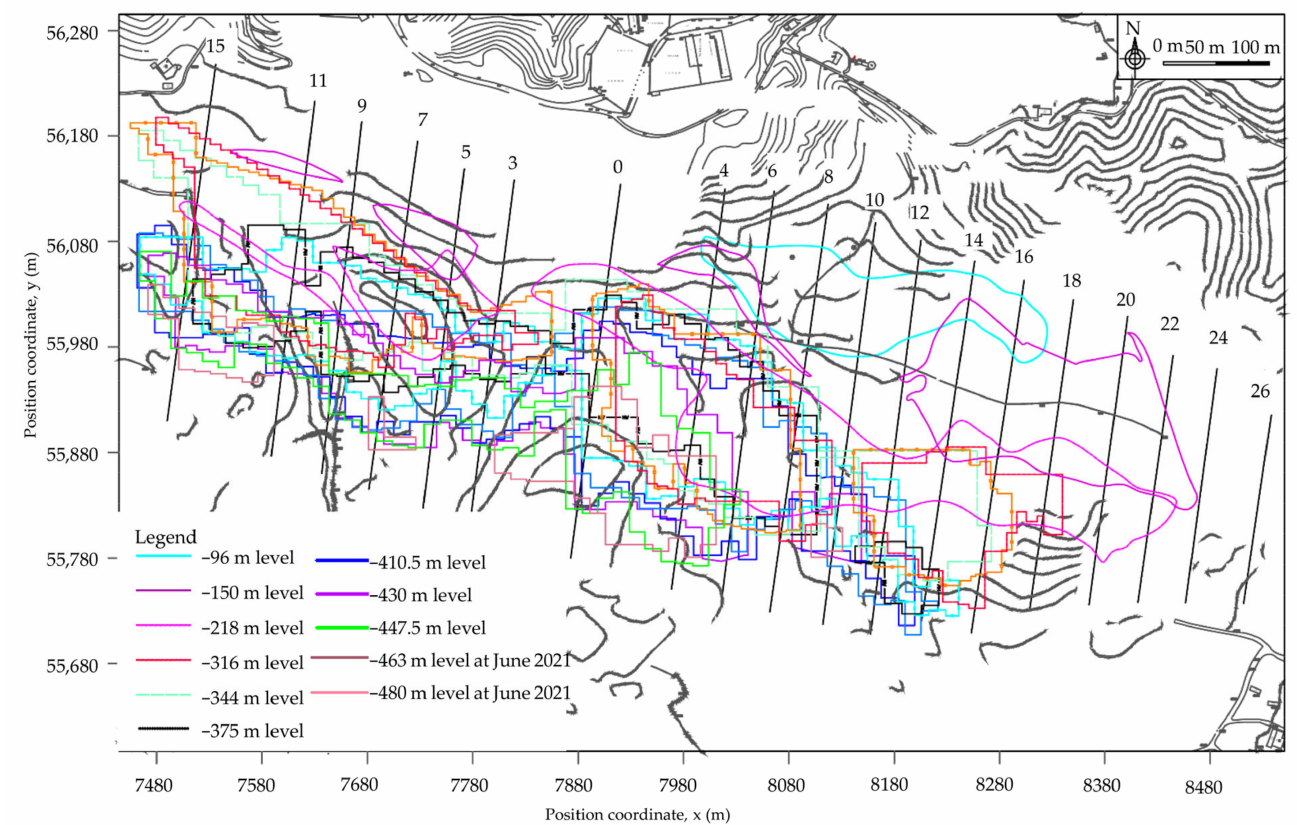
Figure 5. Distribution of the mined-out areas (numbers near the exploratory lines are the names of the geological